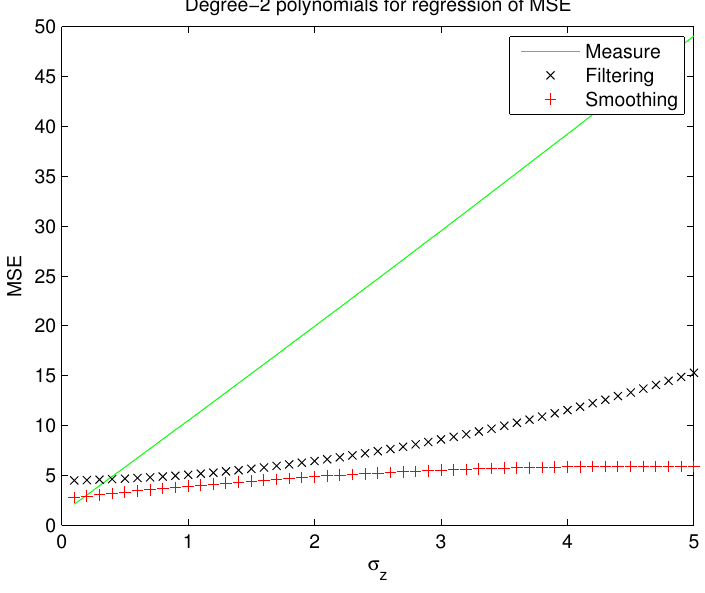
Figure 13. Percentage of distance with respect to the lateral optimum position under ∈ { 0 . 1 , 1 , 5 } ), for J measurement noise ( σ z D 1